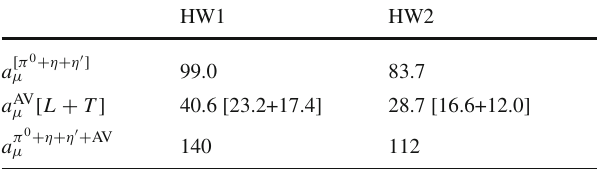
Table4 CombinedresultsfortheHW1andHW2models,withtheaxial vector contribution split into longitudinal and transverse